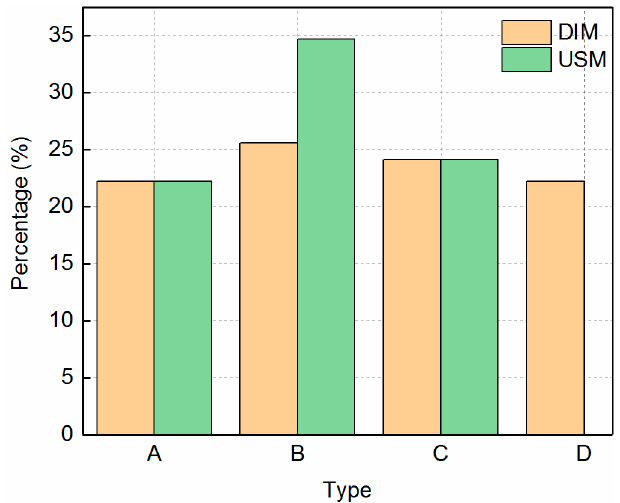
Figure 3. Percentage of interpolation accuracy improvement of DSM compared with USM and DIM in different scenarios.